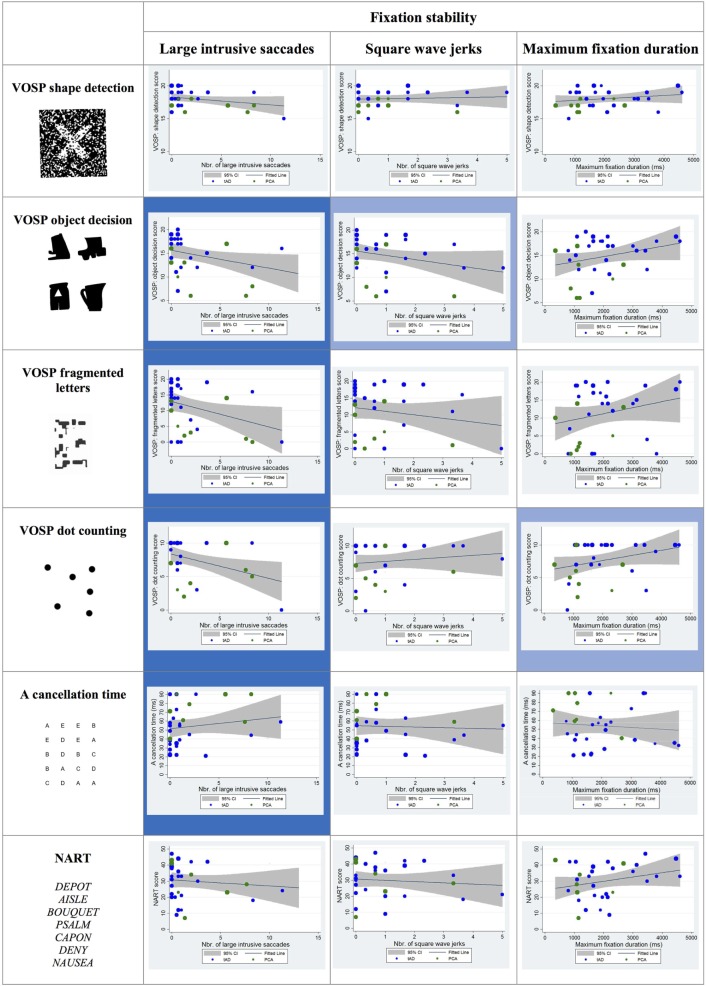
Scatter plots showing correlations between fixation stability metrics and visual cognitive scores for young onset Alzheimer’s disease patients. Statistically significant correlations are marked with a blue background and statistical trends (p > 0.05 and p < 0.10) in a lighter blue. Best fit line and 95% CI are shown. Each data point corresponds to a participant and its size is proportionate to the Mini-Mental State Examination score (indication of disease severity). typical AD (tAD) patients are shown in blue and posterior cortical atrophy (PCA) in green.